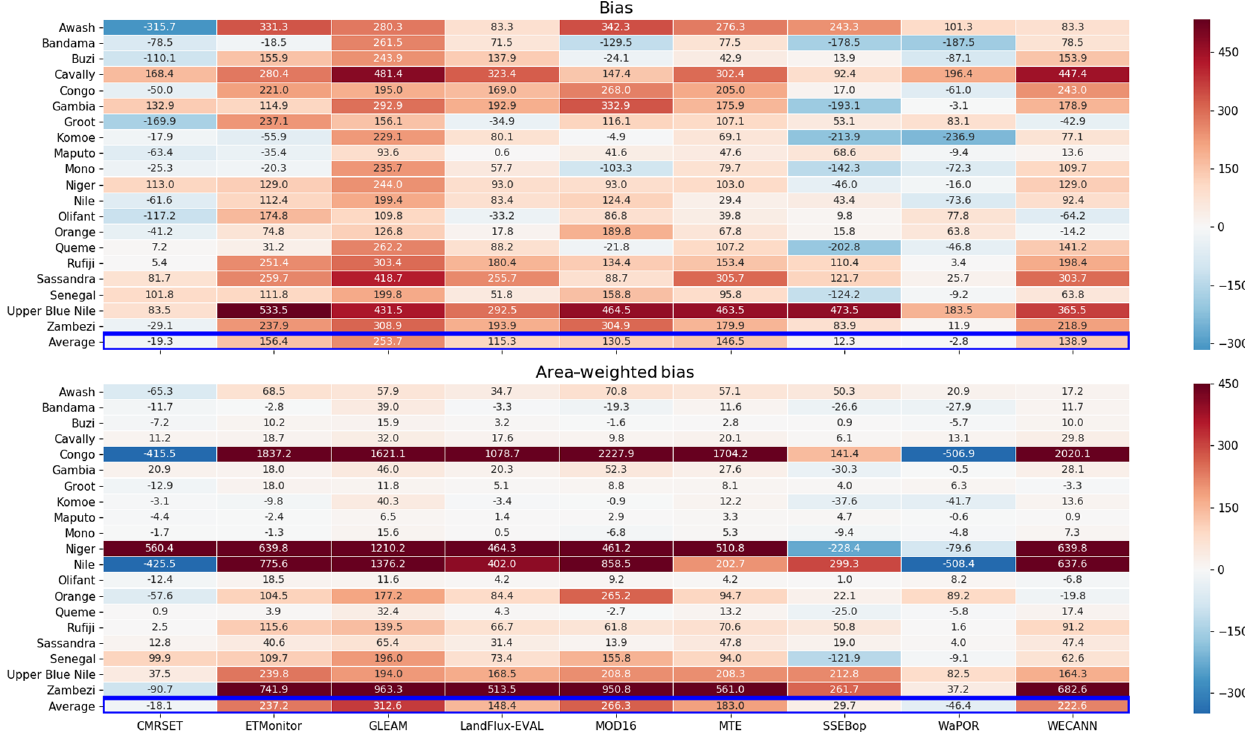
Figure 7. (a) ET WB estimation for 28 major basins in Africa using P − Q . (b) The final basins analysed after analyses to discount basins with trends in ET WB , P and/or Q .